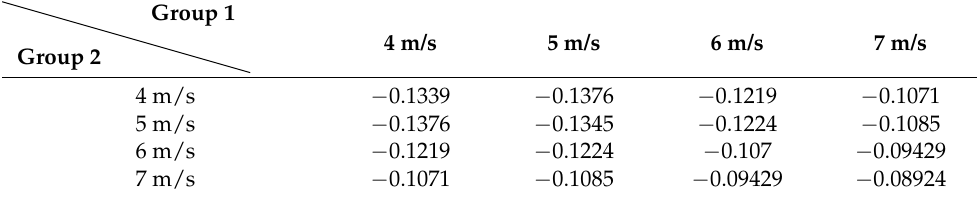
Table 3. Damping coefficient for TM1 of SG under different operating conditions.